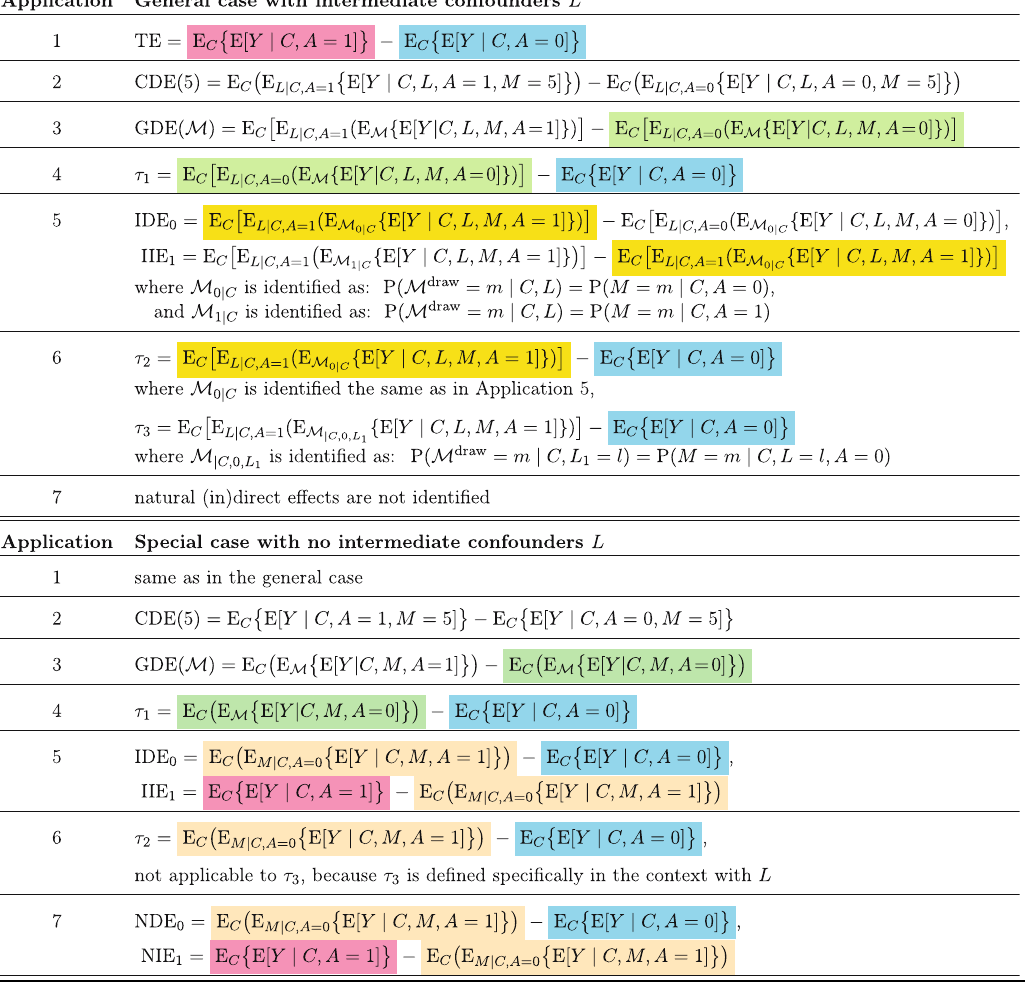
Table 5: Identi fi cation results for the e ff ects in the applications ( top panel, see assumptions in relevant sections ) and their simplication in the special case with no L ( bottom panel